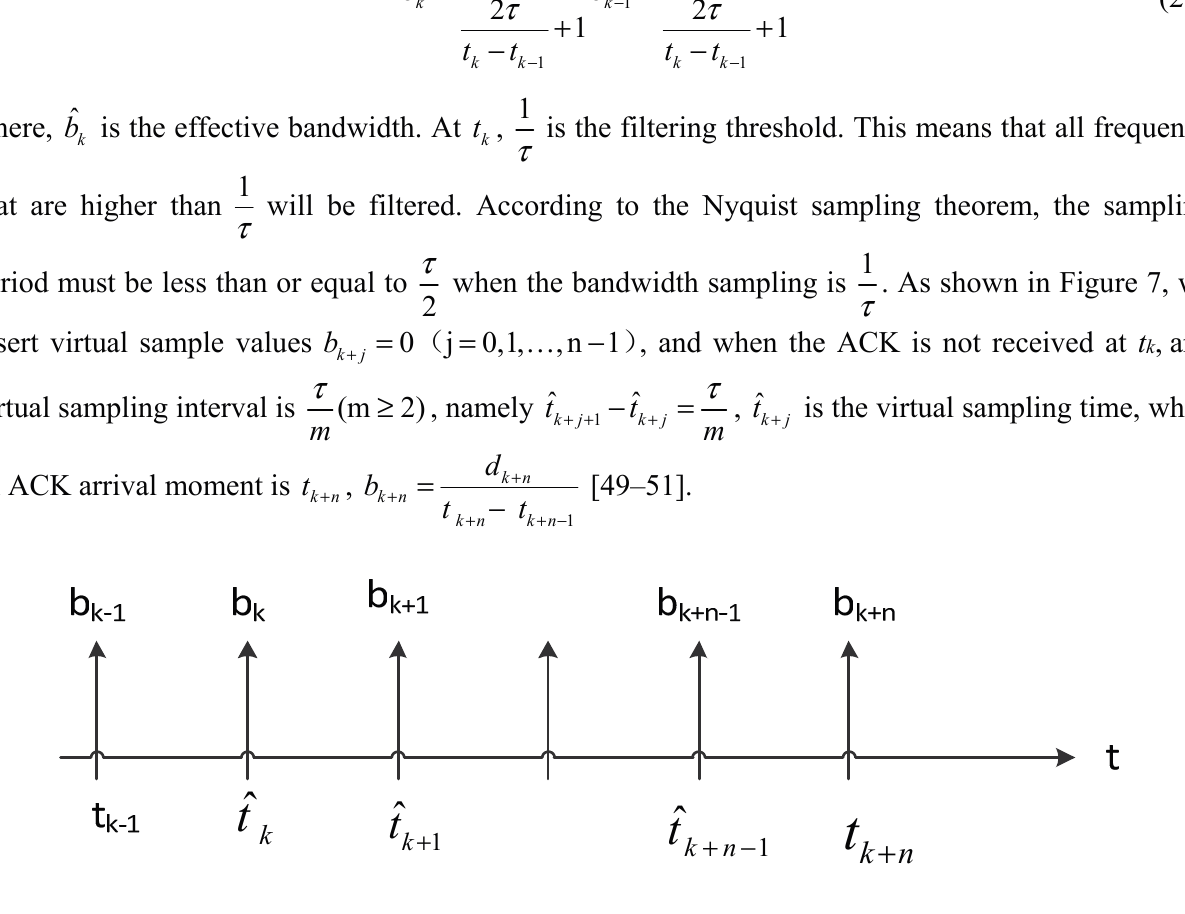
Figure 7. inserting virtual